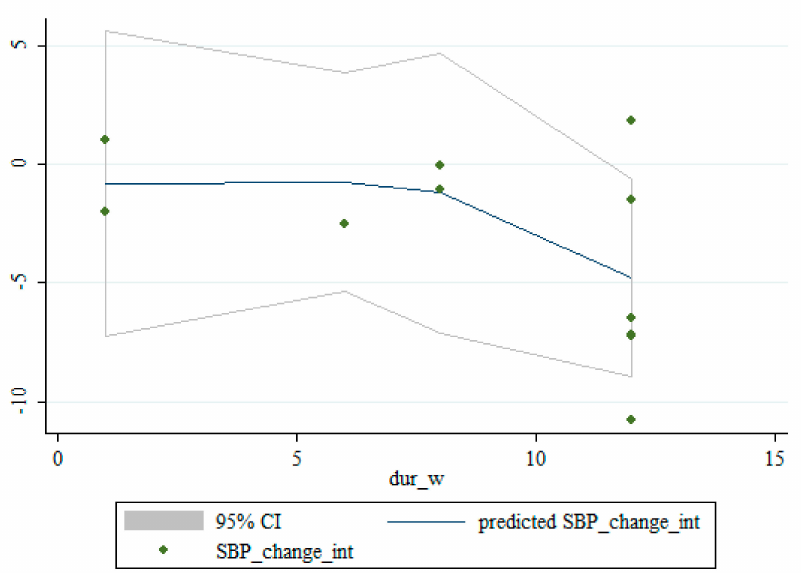
Figure 5. Non-linear dose-response relationships between saffron supplementation and absolute mean differences. Dose-response relationships between the duration of intervention and absolute mean differences in